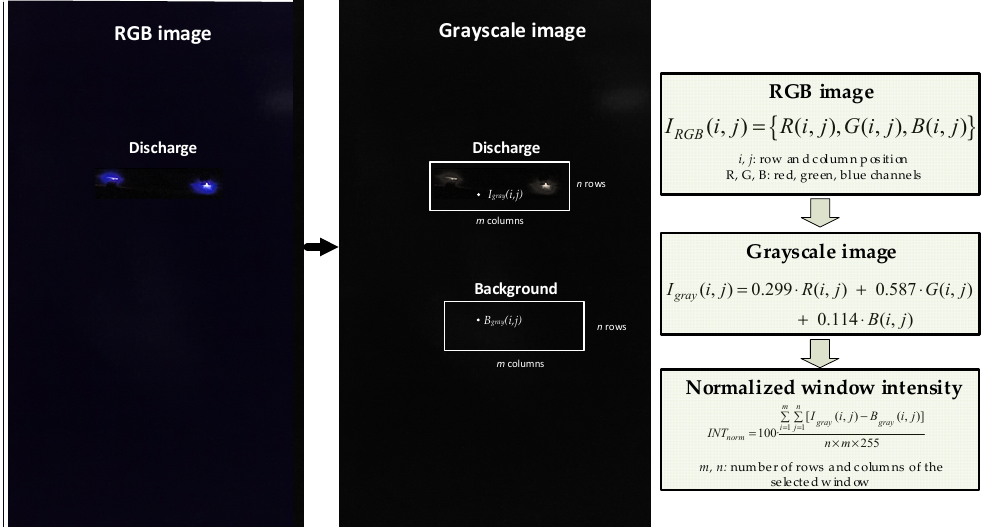
Figure 1. Calculation process of the normalized intensity of the discharges obtained from digital RGB images.